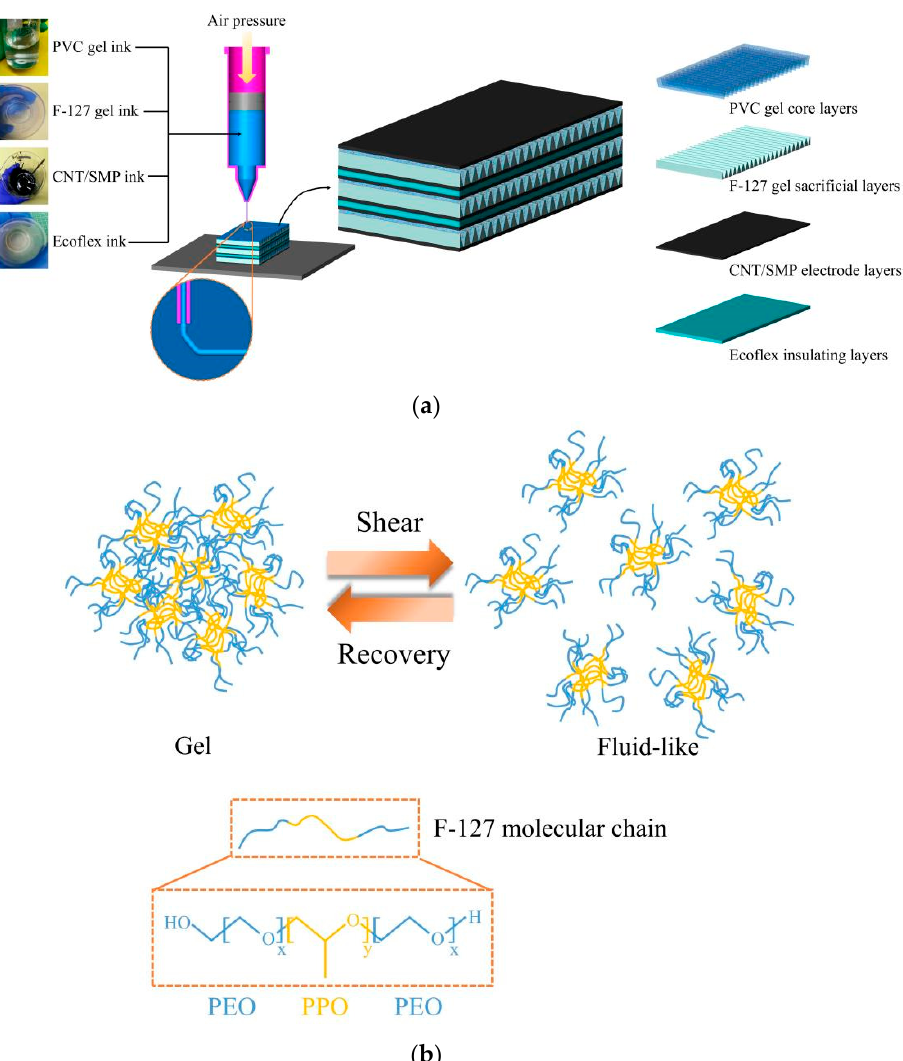
Figure 2. ( a ) Schematic diagram of the printing process of the artificial muscle structure. ( b ) Schematic diagram of the thixotropic property of the F-127 gel ink.